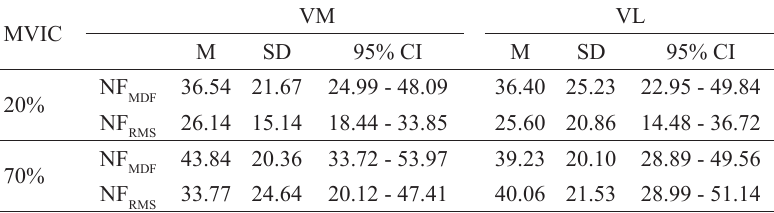
Table 1. Mean (M), standard deviation (SD) and confidence interval (95% CI) for the normalized time values (%) of MDF slope coefficient (MF ) and RMS slope coefficient (MF ) at 20% and 70% of maximum voluntary isometric contraction (MVIC) for vastus medialis (VM) and MDF RMS vastus lateralis